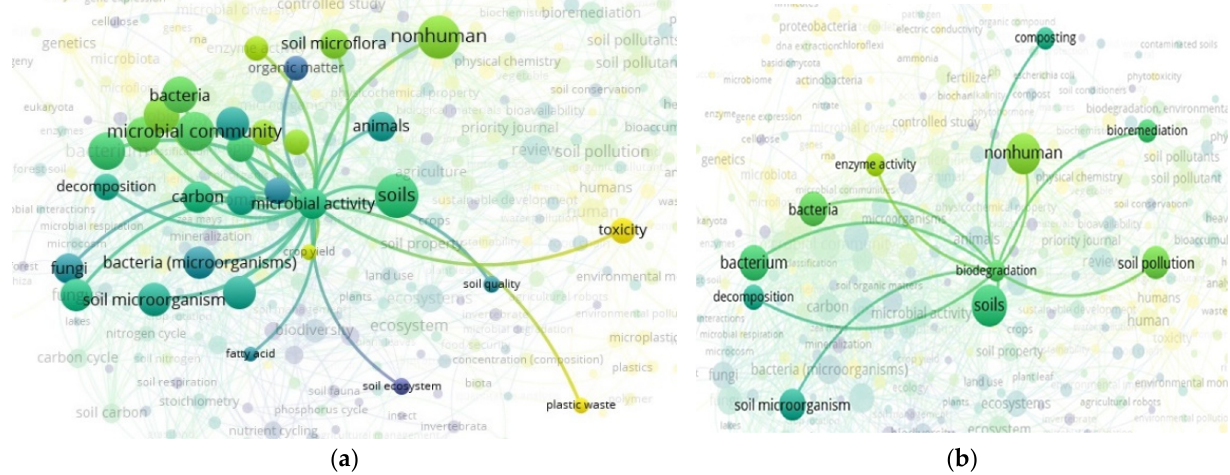
Figure 7. Analyzing Scopus results with the VOSviewer. The microbial activity ( a ) and the biodegradation ( b ).